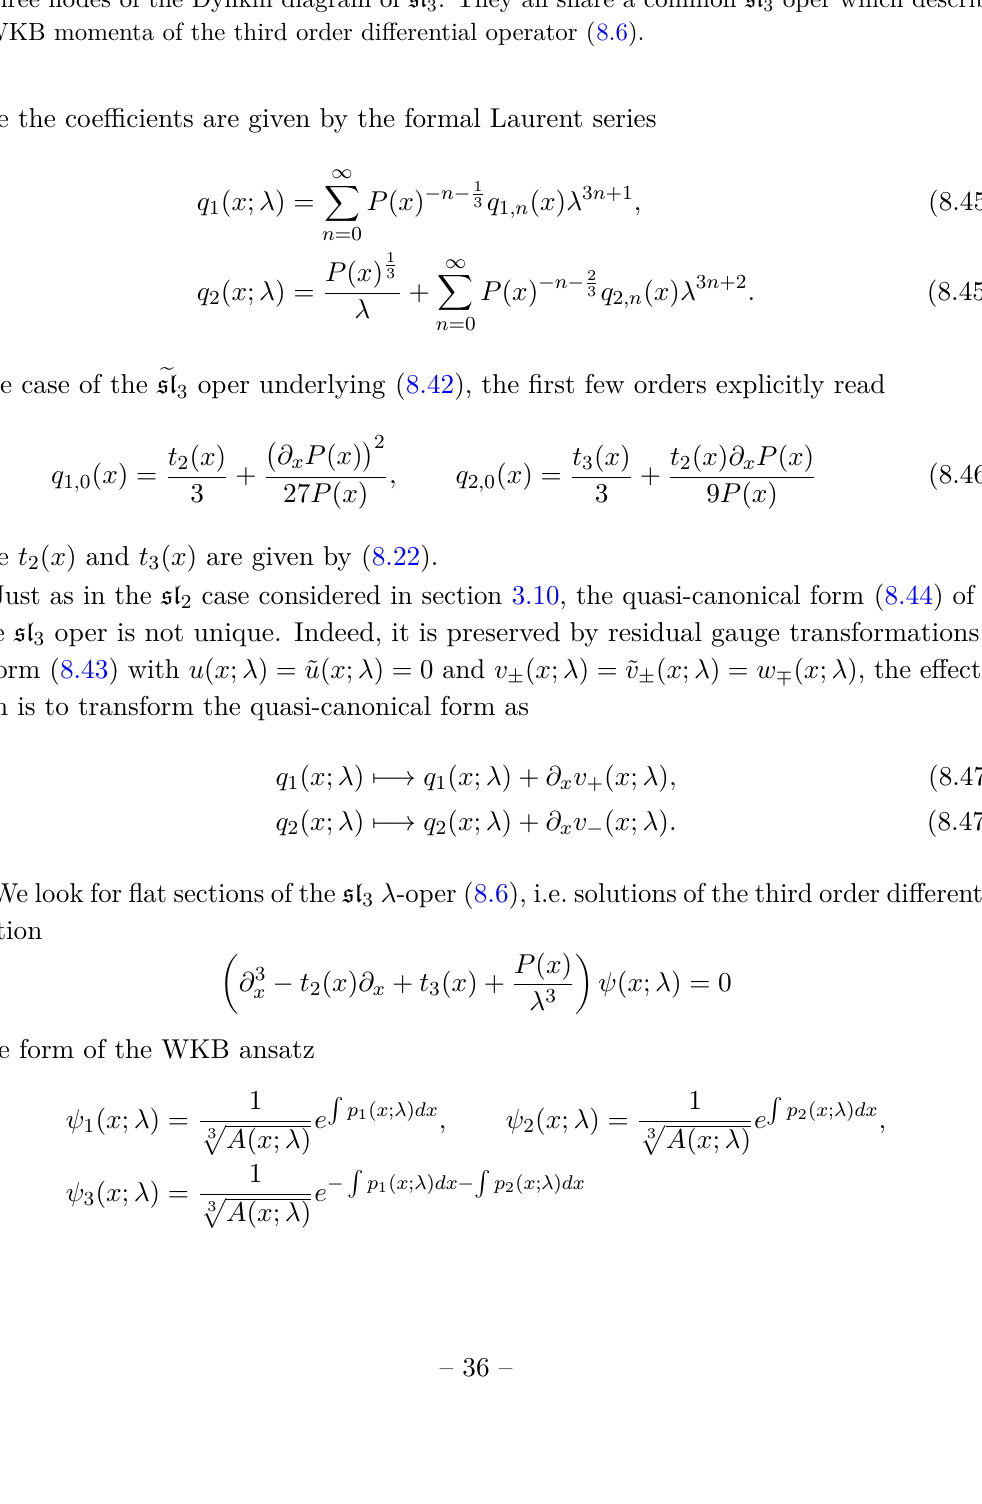
. They all share a common e sl oper which describes 3 3